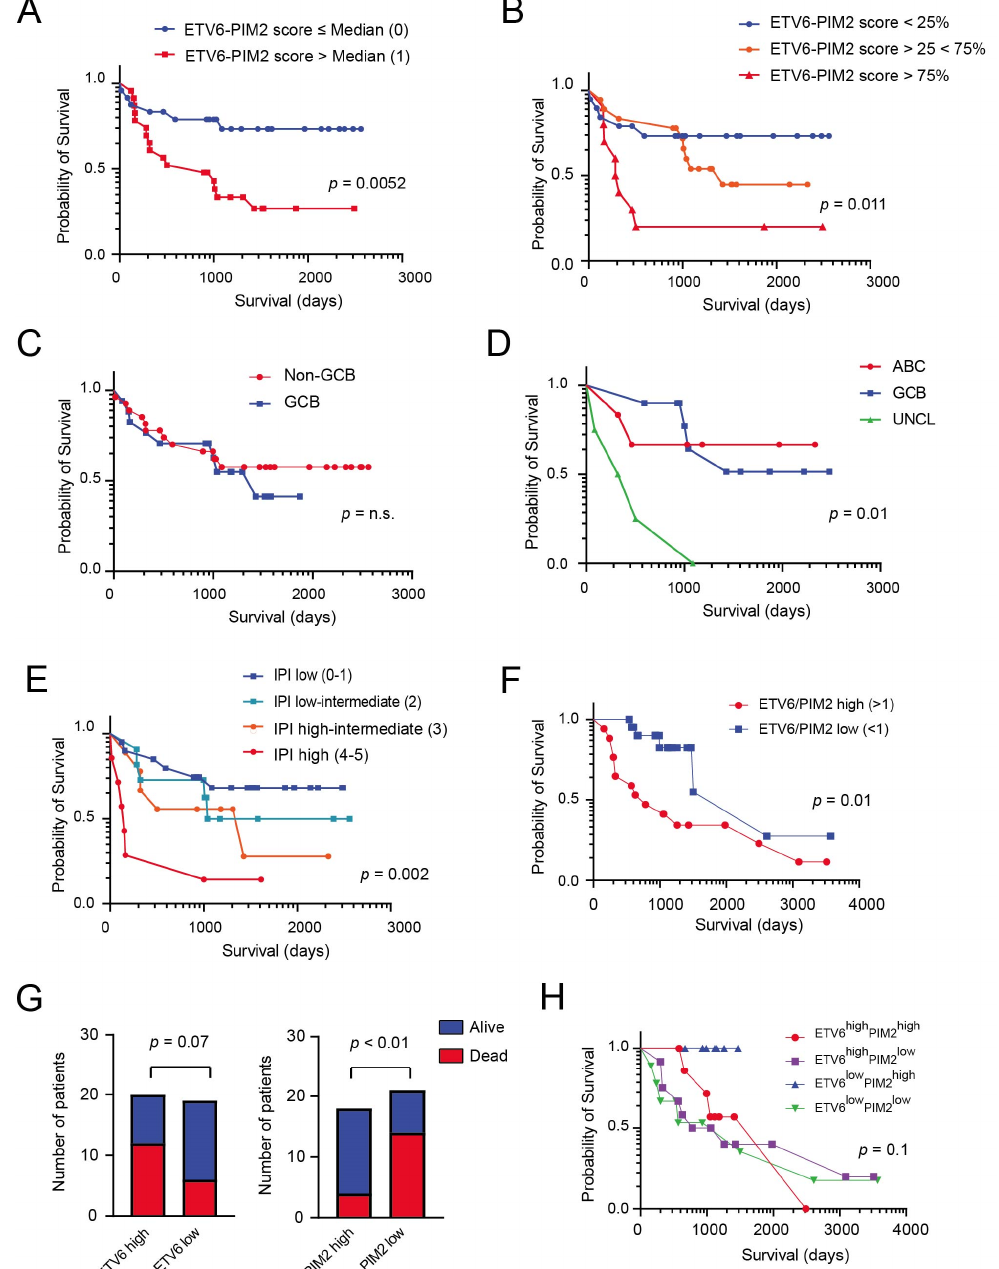
Figure 3. Kaplan–Meier curves of OS in DLBCL patients treated with chemotherapy and stratified according to various putative prognostic markers. ( A ) Kaplan–Meier curves of OS in two groups identified using the PIM2-ETV6 prognostic score (Group 0: score ≤ median; Group 1: score > me- dian). ( B ) Kaplan–Meier curves of OS in the three groups identified using the tertiles of PIM2-ETV6 prognostic score (<25%, 25–75%, >75% of score). ( C ) Kaplan–Meier curves of OS in the same patients subdivided into GCB and non-GCB subgroups using the Hans immune-histochemical algorithm, which uses three markers (CD10, BCL6 and MUM1) to separate GCB DLBCL from non-GCB DLBCL. ( D ) Kaplan–Meier curves of OS in the same cohort of patients subdivided into COO subgroups (ABC, GCB, UNCL) using the Lymph2Cx assay. ( E ) Kaplan–Meier curves of OS in the same